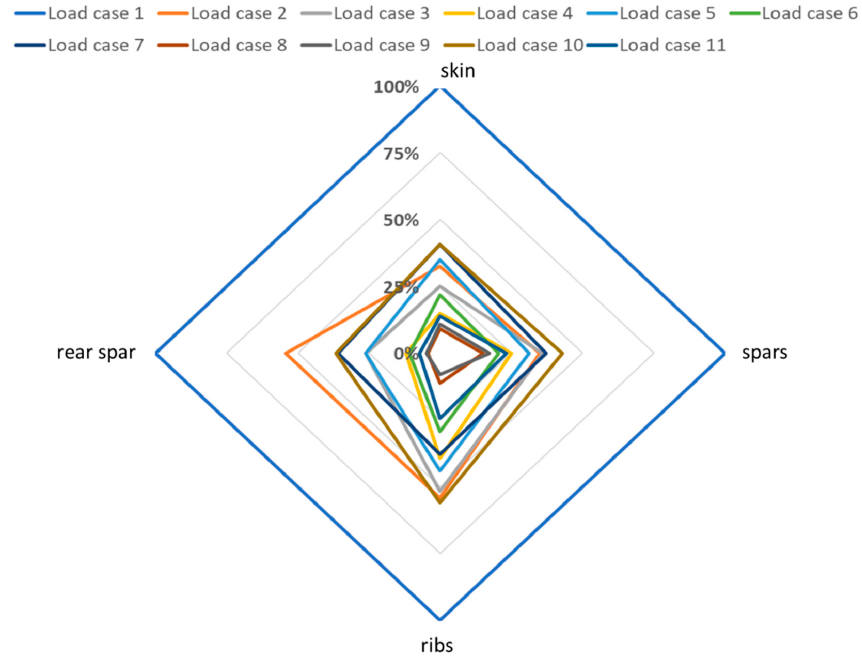
Figure 3. Load case comparison in terms of normalized stress level for the main subparts of the structure. The skin subpart exhibited the highest level of stress: a peak has been noticed on the upper zone of the skin, close to the cap of the rear spar, leading to a stress concentration. It has been just this outcome to justify the investigation hereafter presented.